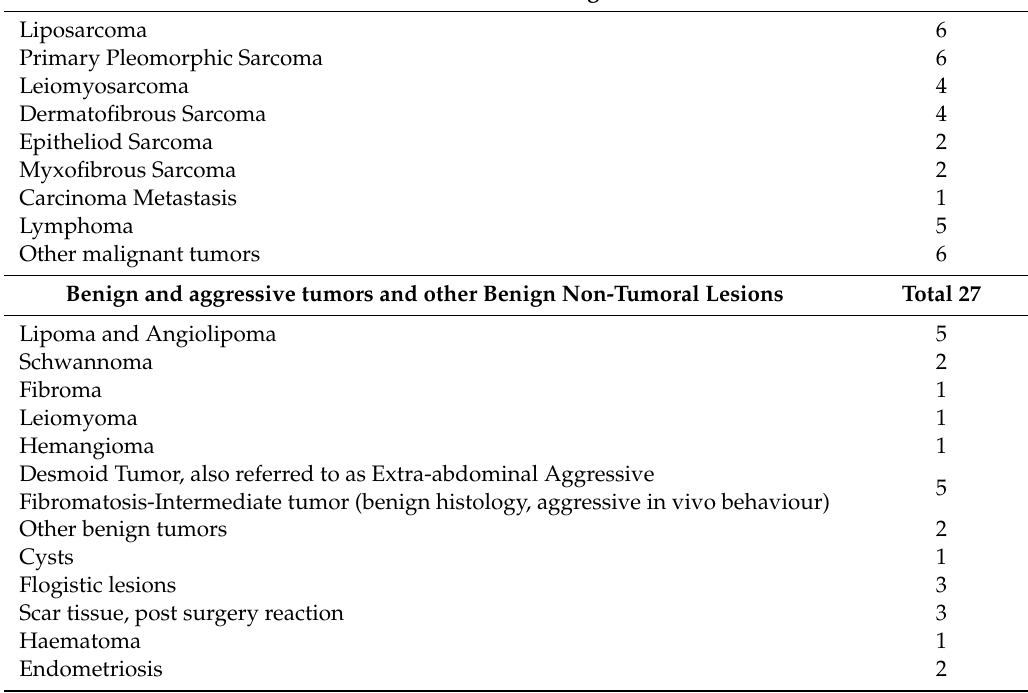
Table 1. Histopathological diagnoses of the 63 soft tissue superficial tumors included in this study. Soft Tissue Sarcoma (STS) and Non STS Malignant Tumors Total 36